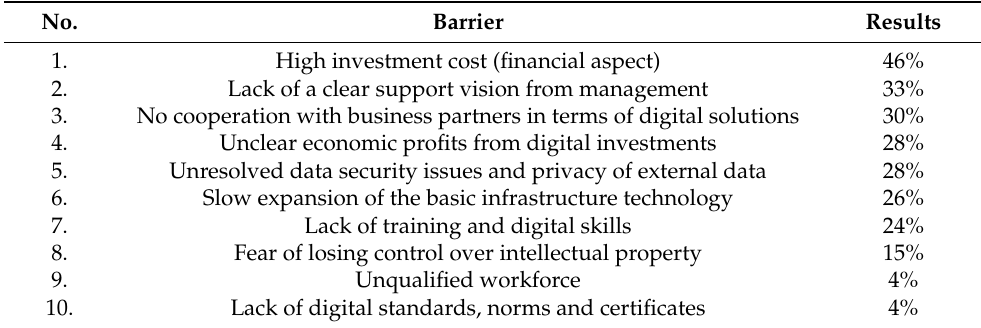
Table 1. Results of the study on barriers affecting the effectiveness of the implementation of change in manufacturing.